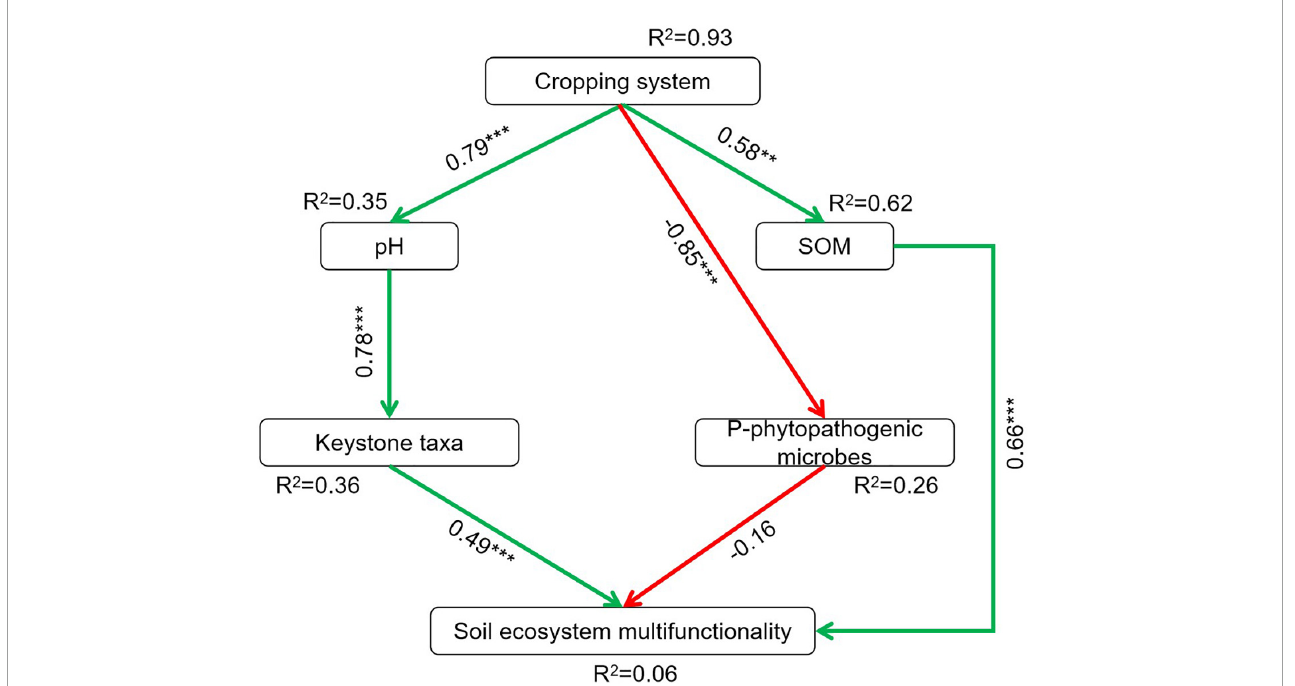
FIGURE6 Structural equation modeling for the direct and indirect relationships of cropping systems on soil ecosystem multifunctionality. SOC, soil organic carbon. Red and green lines indicate significant negative and positive path coefficients, respectively; ** P < 0.01, *** P < 0.001. χ 2 /df = 1.096, P = 0.362, RMSEA = 0.071. P-phytopathogenic microbes, potentially phytopathogenic